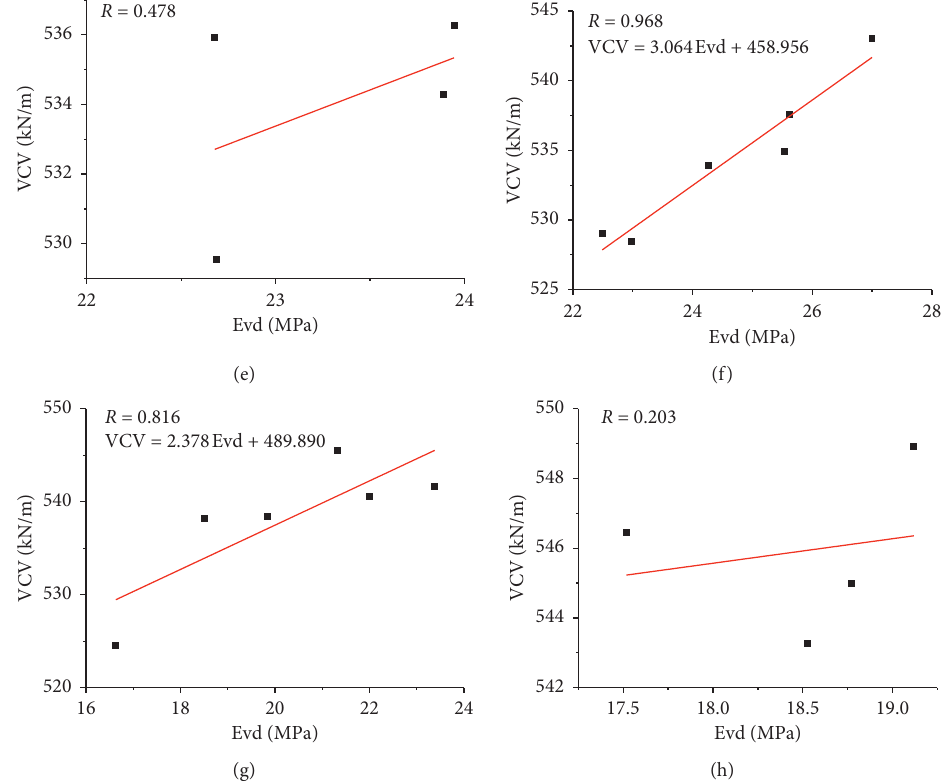
Figure 7: E vd mean and their corresponding VCV mean. (a) WC 1; (b) WC 2; (c) WC3; (d) WC 4; (e) WC 5; (f) WC 6; (g) WC 7; (h) WC 8.